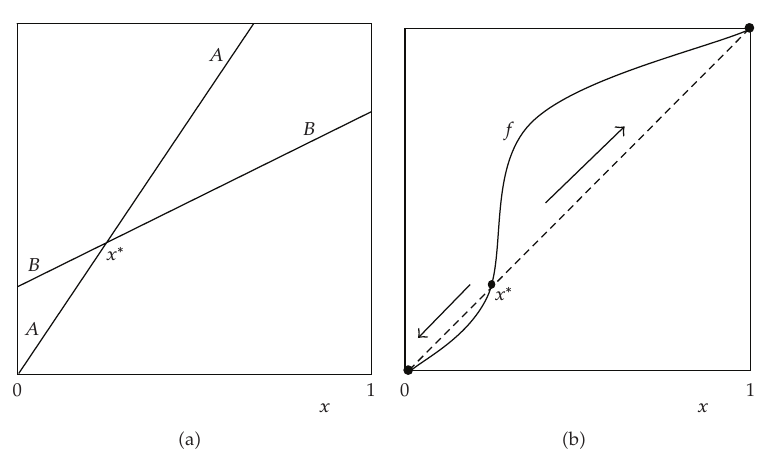
Figure 1: (cid:2) a (cid:3) Payo ff functions A (cid:2) x (cid:3) (cid:7) 1 . 5 x and B (cid:2) x (cid:3) (cid:7) 0 . 25 (cid:8) 0 . 5 x . (cid:2) b (cid:3) Function f obtained with the same payo ff functions as in (cid:2) a (cid:3) and parameters δ A (cid:7) 0 . 3, δ B (cid:7) 0 . 7, λ (cid:7) 20 with switching function g (cid:2) · (cid:3) (cid:7) (cid:2) 2 /π (cid:3) arctan (cid:2) · (cid:3)